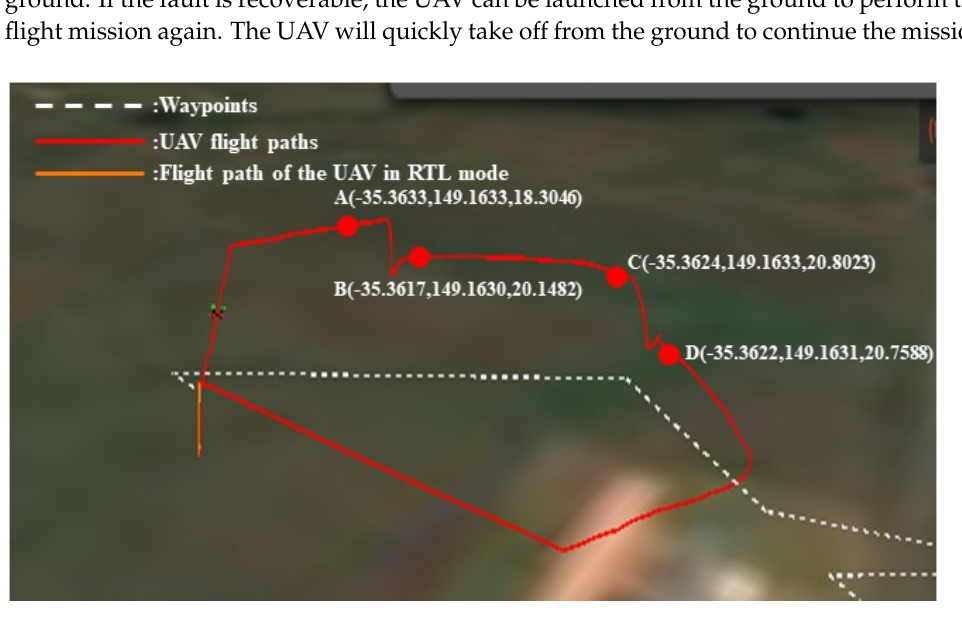
Table 3. Parameter se tt ings in the engine failure simulation.